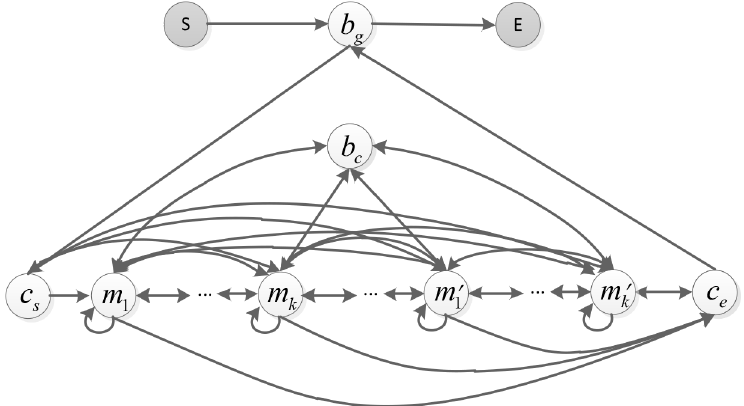
Fig 2. The SMCis HSMM state transition diagram. Nodes represent emission states, including motifs, inter-module backgrounds and intra-module backgrounds. Shadow nodes represent the initial and termination states of the model and the initial and termination states of the CRMs. Arrows indicate permissible transitions between states.